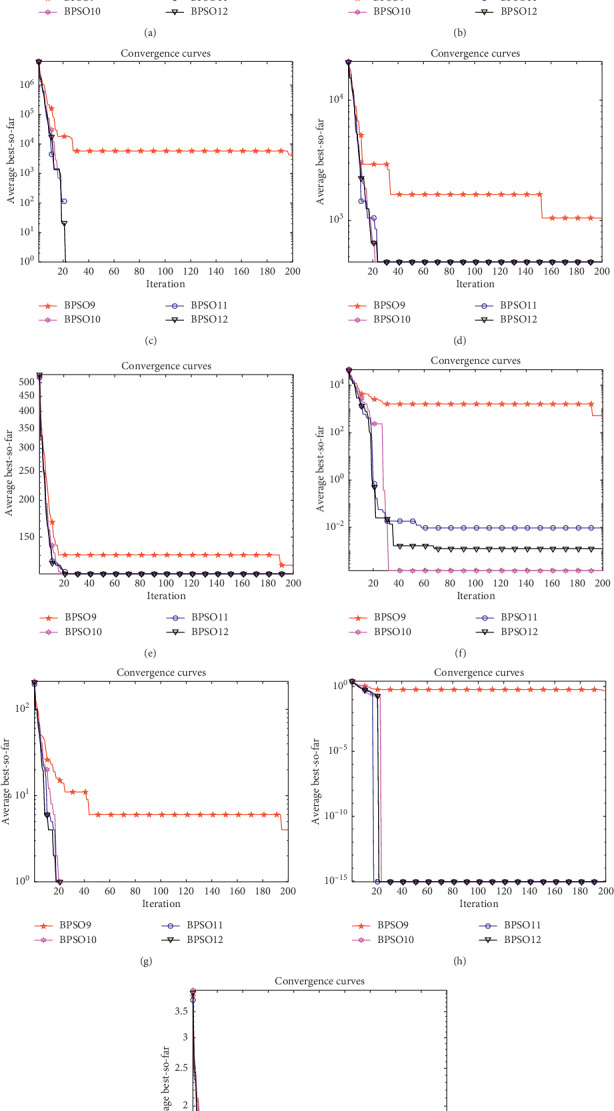
Convergence curves of the benchmark functions under D=30. (a) F1. (b) F2. (c) F3. (d) F4. (e) F5. (f) F6. (g) F7. (h) F8. (i) F9.